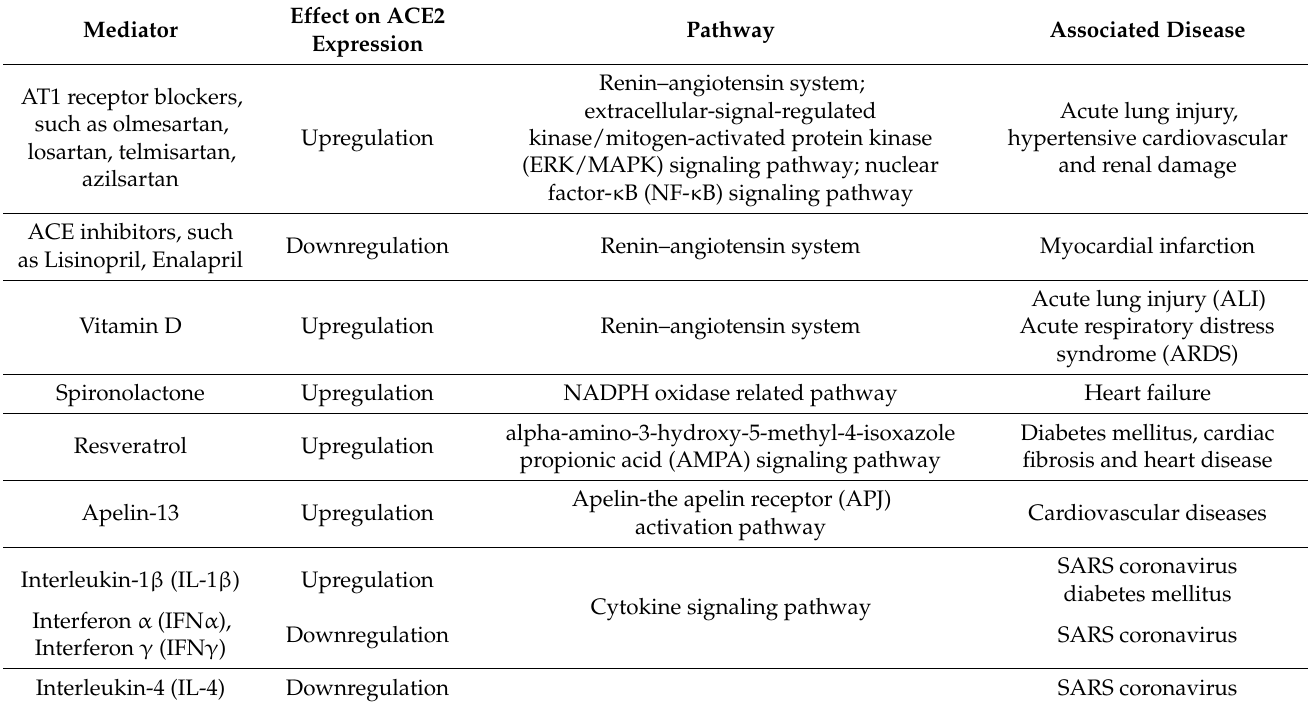
Table 1. The regulation of angiotensin-converting enzyme 2 (ACE2) by different